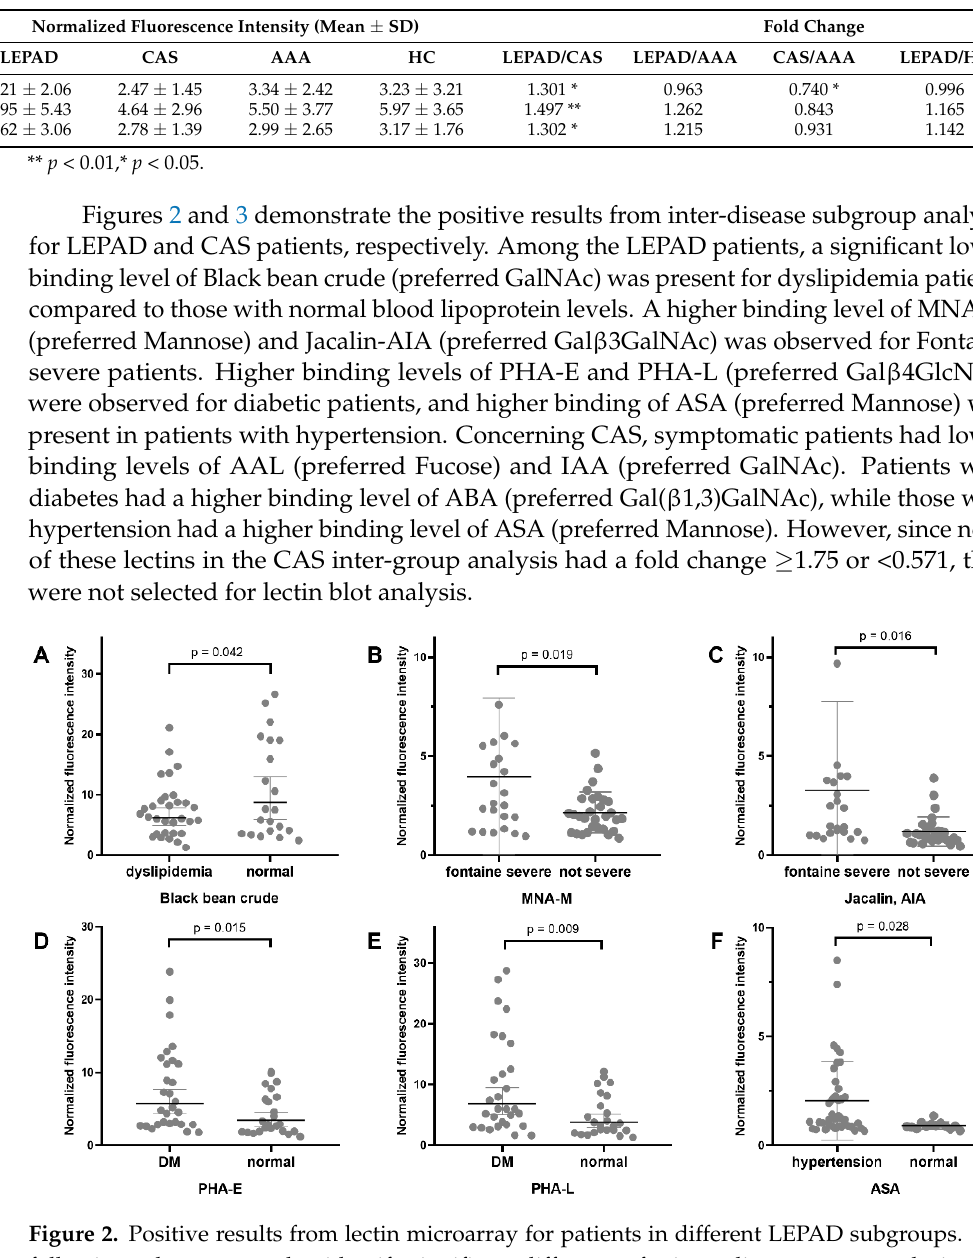
Table 3. Positive results from lectin microarray inter-group analysis.